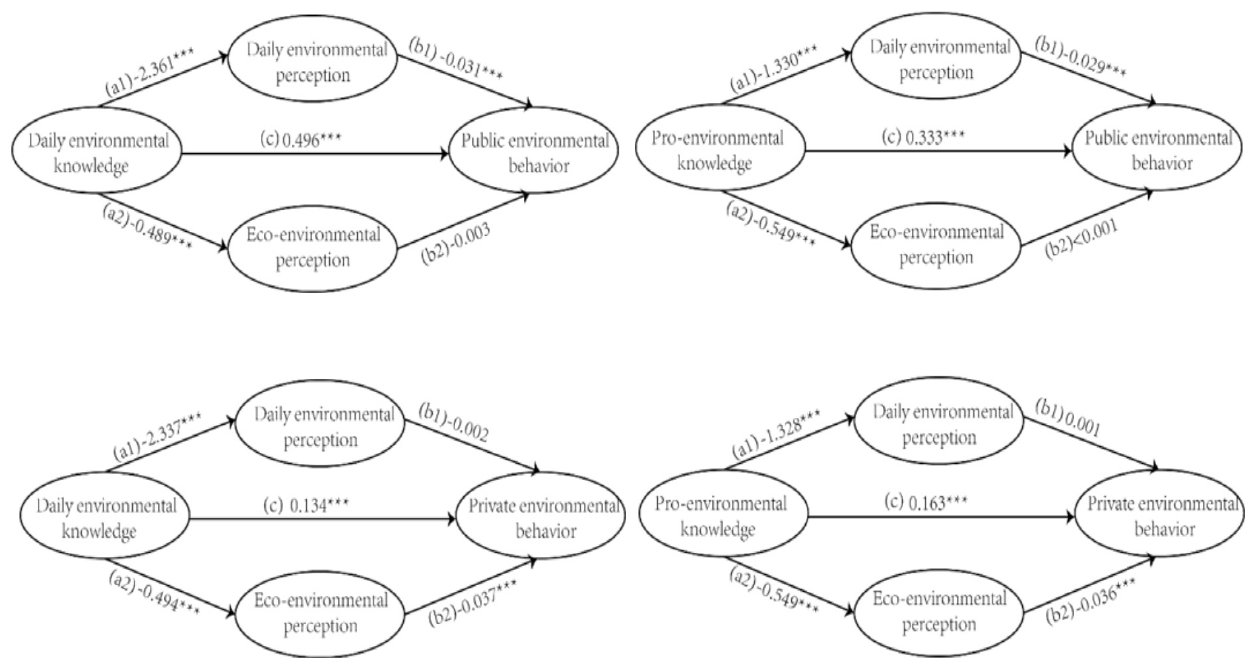
Figure 1. Final model estimations with standardized beta weight (SE). Note. *** p < 0.05.